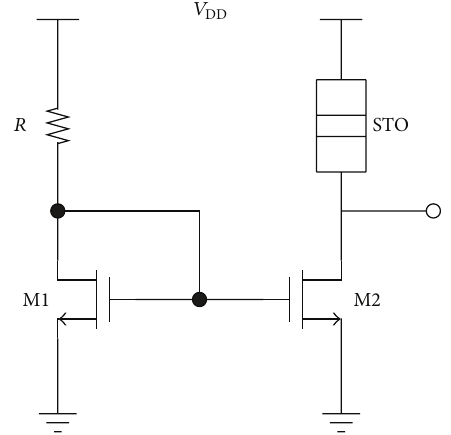
Figure 3: Current mirror circuit integrated with the MTJ-STO elements and the CMOS